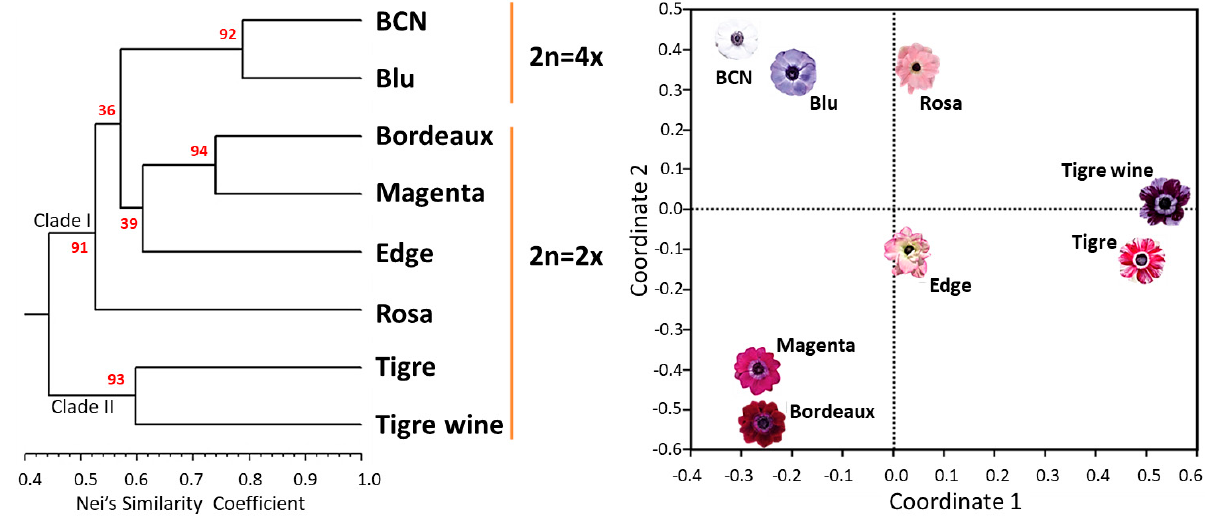
Figure 7. UPGMA dendrogram ( left ) and PCoA analysis of the eight varieties based on 62 microsatellite loci ( right ). Bootstrap values (%) are reported in red.